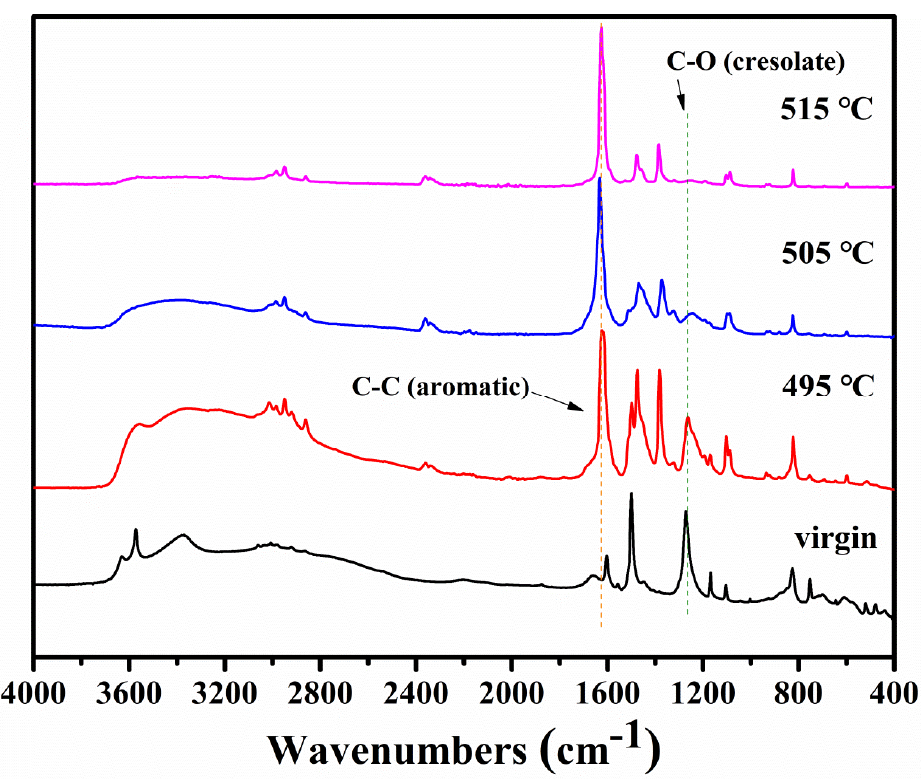
Figure 8. FTIR spectra of sodium p -cresolate (soluble part) with temperature.